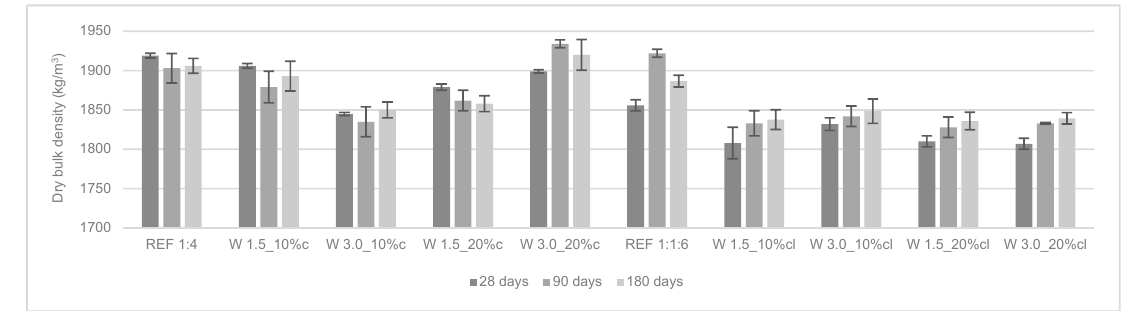
Figure 4. Dry bulk density of the hardened mortars.